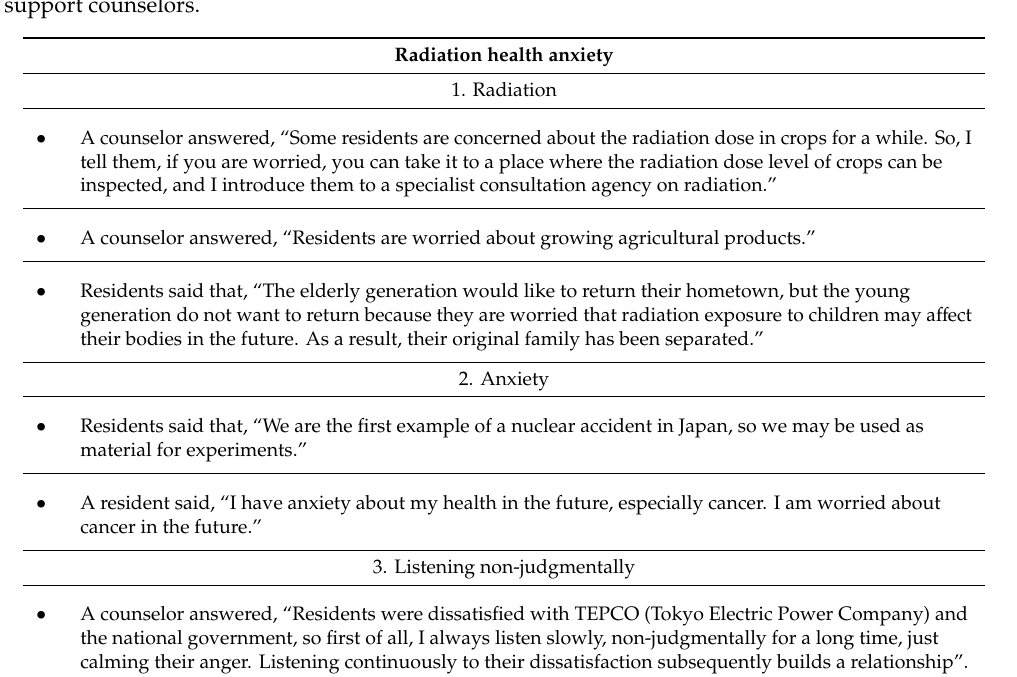
Table 2. Main answers from the survey results of gatekeeper training program needs among livelihood support